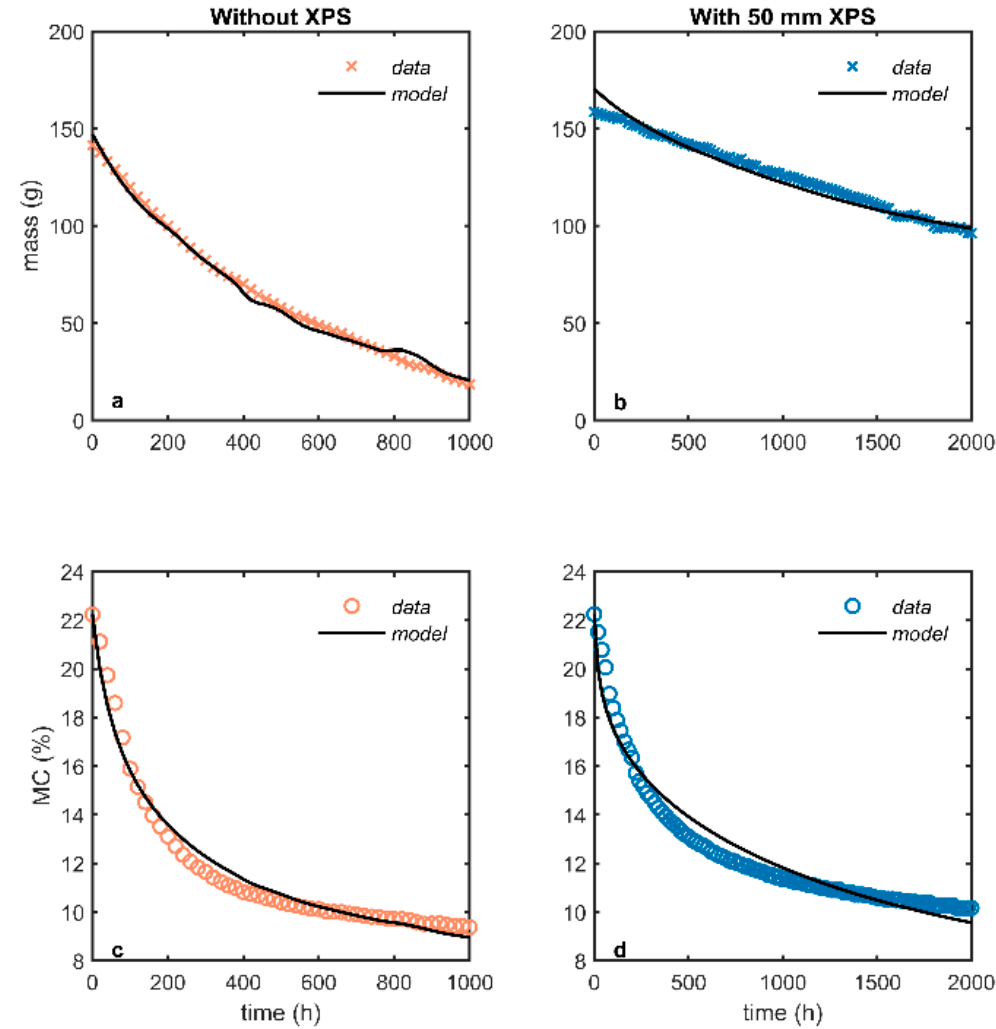
Figure 8. Measurement versus model predictions for both poly walls (0.15 mm polyethylene covering the framing lumber). Subfigures ( a ) mass results, and ( c ) MC results, represent the wall without XPS covering the OSB, while ( b ) mass results, and ( d ) MC results, represent the wall with 50 mm XPS insulation covering the OSB.